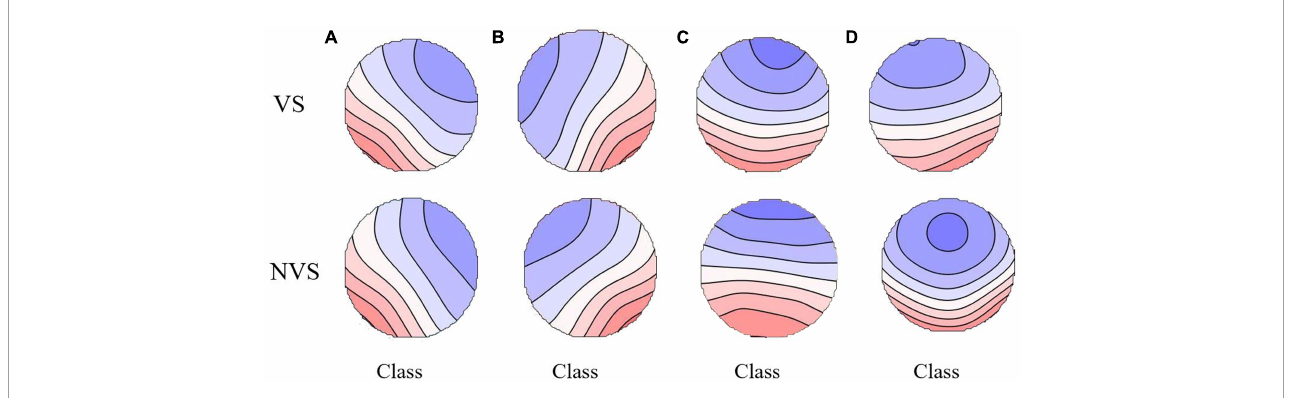
FIGURE1 The spatial configuration of the four microstate classes of the two groups. VS, violent patients with schizophrenia; NVS, non-violent patients with schizophrenia.